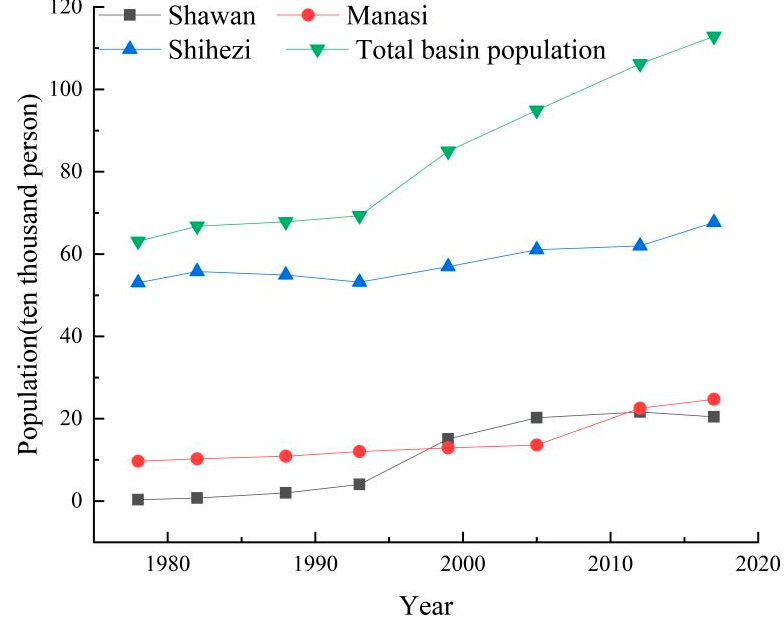
Figure 5. Population evolution in the study area.